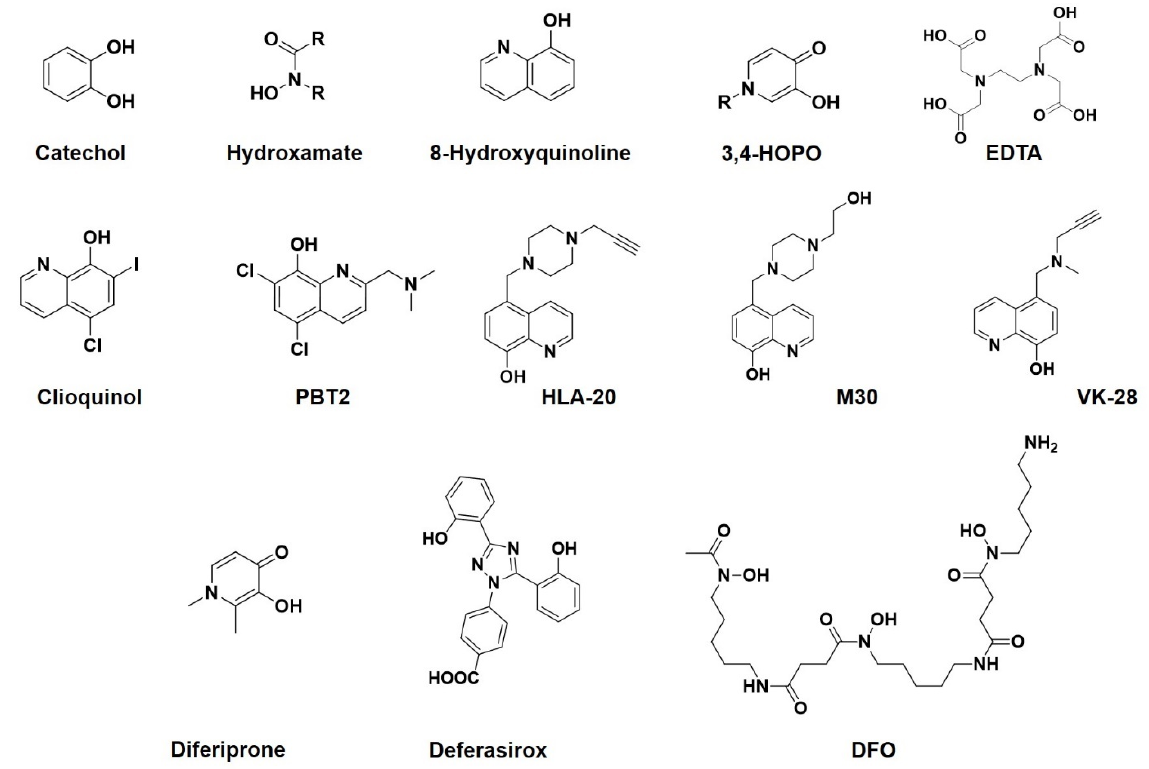
Figure 2. Selected iron (III) chelators.